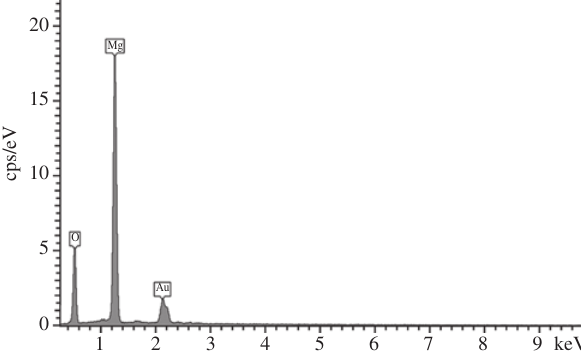
Figure 3: The MgO nanostructures energy dispersive X-ray (EDX) analysis.